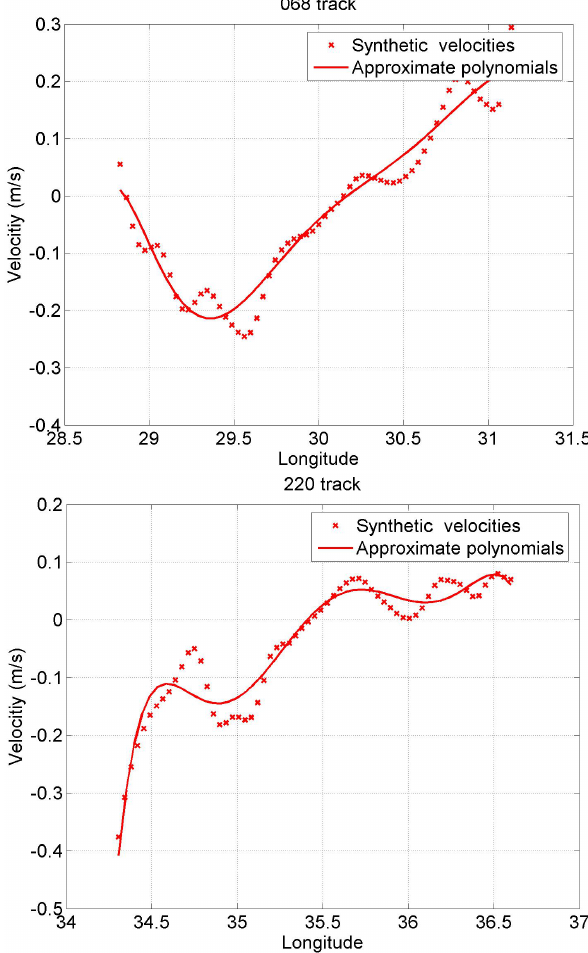
Fig. 3. Synthetic velocities computed in Black Sea along tracks No. 68 and No. 220 of Topex/Poseidon from drifters measurements and SLA and their polynomial